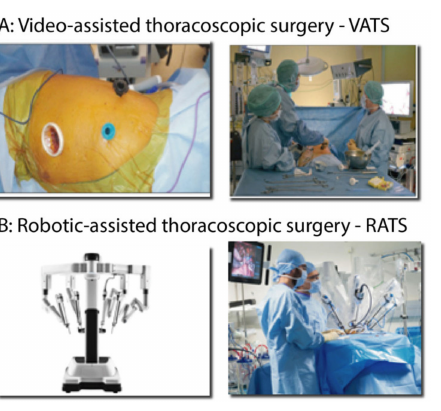
Figure 2. Video-assisted and Robotic-assisted thoracoscopic surgeries. ( A ) Surgical skin incisions for a left lung resection by video-assisted thoracoscopic approach (VATS) and operators setting in the operating room. ( B ) da Vinci (Intuitive Surgical) Xi platform for robotic-assisted thoracoscopic surgery (RATS) and assistant surgeons near the patient during left lung surgery performed with the X